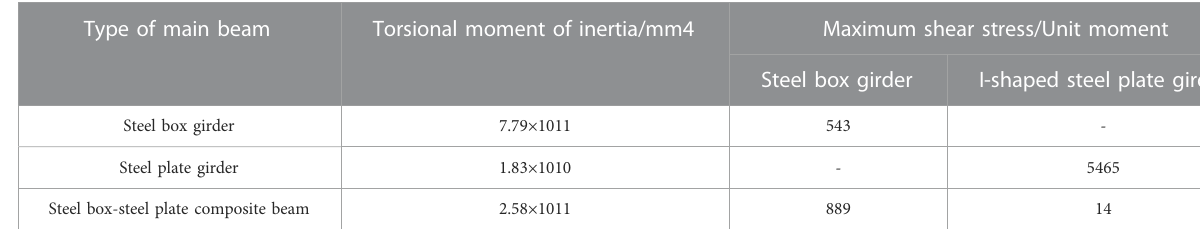
TABLE 2 Comparison of torsional characteristics.